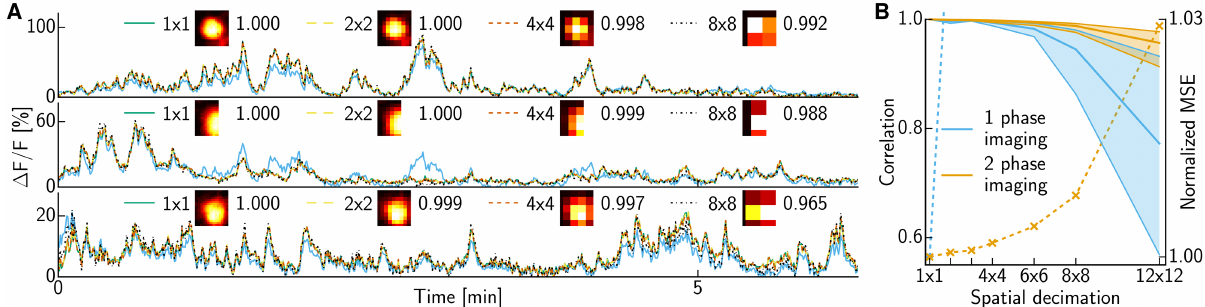
Fig 3. Low spatial resolution light-sheet imaging with previously identified cells. (A) Inferred traces for the three neuronsin Fig 2. Shapes were decimatedby averaging2 × 2, 4 × 4 or 8 × 8 pixels. The legendshows the resulting shapes A l as well as the correlation between the calcium traces C l inferred from the decimateddata versus the originaltraces C 1 obtained from the non-decimated data. Further, the results obtained with merely 1-phaseimagingfor decimationby 8 × 8 pixels are shownas cyan traces. (B) Correlation(solid, left y-axis) between C l and C 1 for all cells recovered from this patch. Thick lines show the median,thin lines and shadedregion the interquartile range (IQR). The correlationdecays slowly as l increasesfor 2-phaseimaging(orange)but drops abruptly if the shapes A l are estimated directly from decimateddata (cyan) instead of being decimatedfrom the shapes A 1 estimated from a standard-resolutionimagingphase. Mean- squared-error (dashed, right y-axis) normalizedso that without decimationthe value is